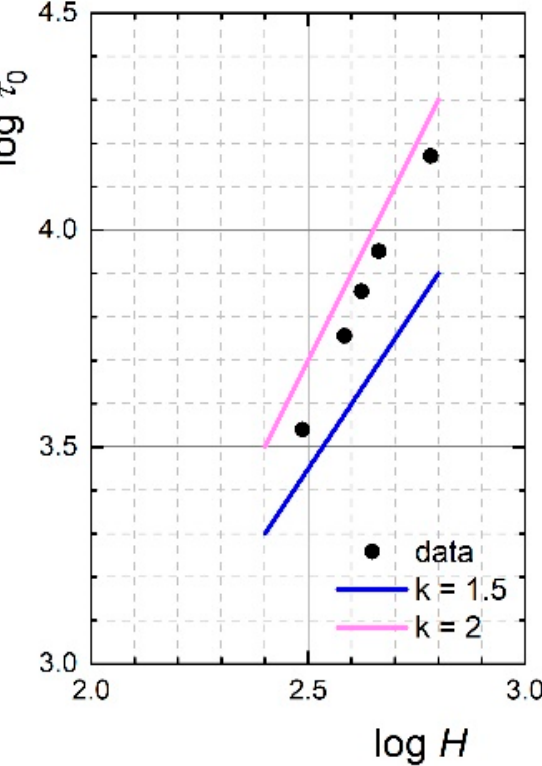
Figure 3. Dependence of the dynamic yield stress on the applied magnetic field for the MR slurry.